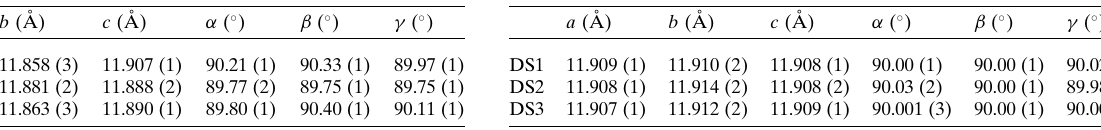
Table 5 Lattice parameters from unconstrained refinement without distortion compensation.